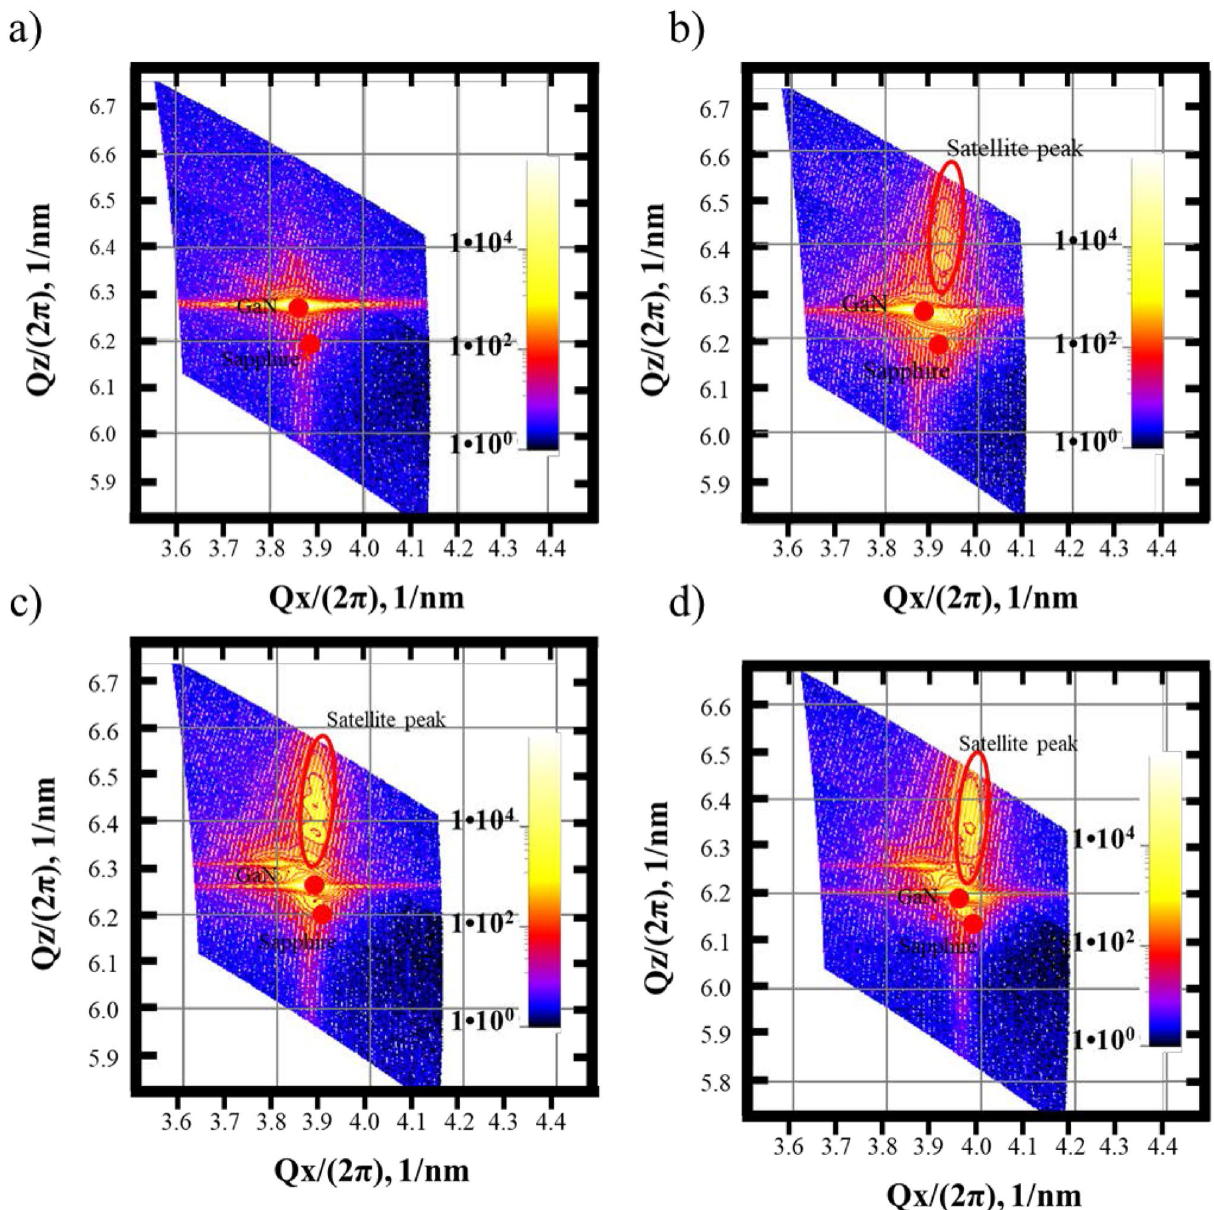
Figure 7. HR-XRD RSM scan along (11–22) for samples ( a ) S1, ( b ) S2, ( c ) S3 and ( d )